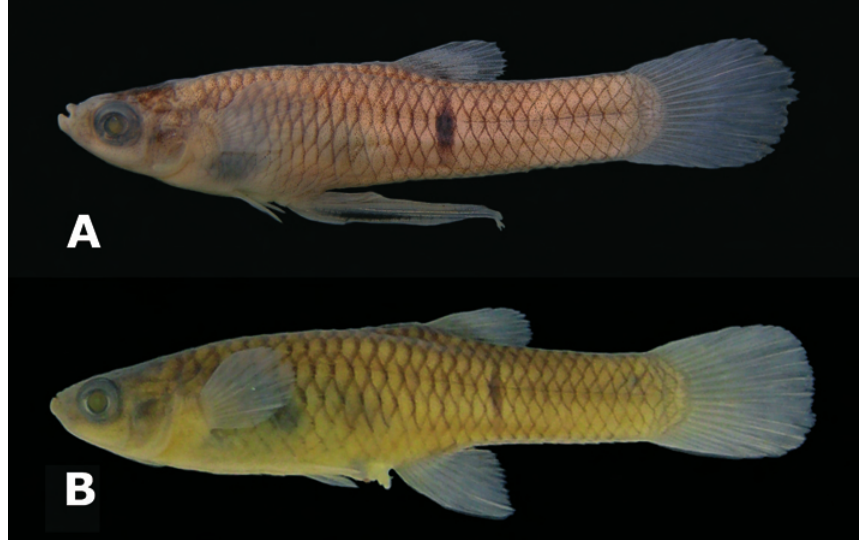
Fig. 10. Phalloceros caudimaculatus , MCP 20158, arroio Feitoria, Sapiranga, Rio Grande do Sul, Brazil. (A) Male, 24.5 mm SL; (B) female, 36.8 mm